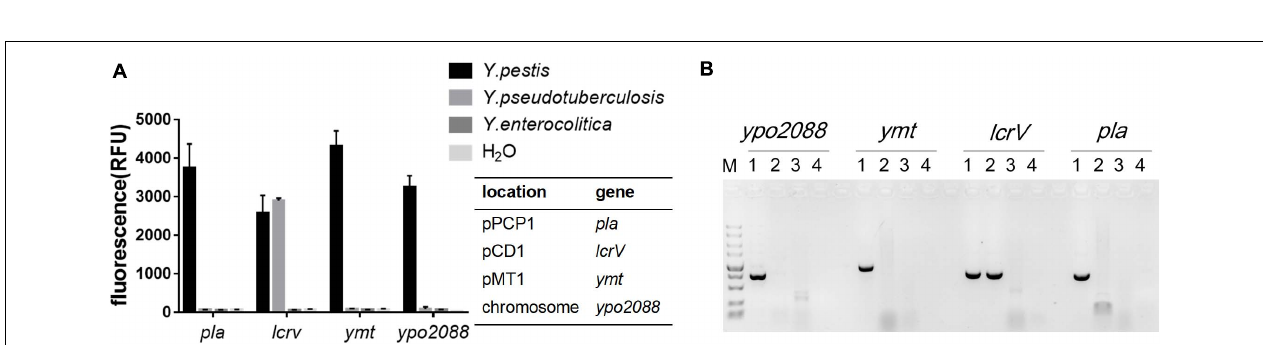
FIGURE 3 | The specificity of the RPA-Cas12a detection of Y. pestis . (A) Specificity of RPA-Cas12a. Data are represented as mean with SD ( n = 3). (B) Specificity of PCR assay for the same DNA templates used in panel (A) . M indicates DNA molecular marker; 1–4 represent Y. pestis strain 201, Yersinia pseudotuberculosis strain Pa3606, Yersinia enterocolitica ATCC9610, and the negative control, respectively. RPA, recombinase polymerase amplification.